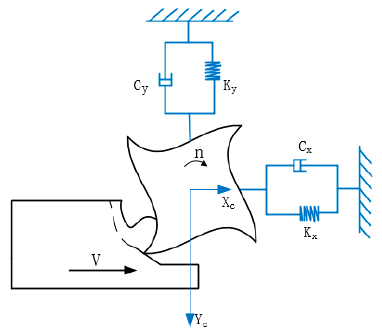
Figure 10. Dynamic model of two degrees of freedom dynamic milling process. the tool induced by vibration, the dynamic equation is a delay differential equation set with excitation